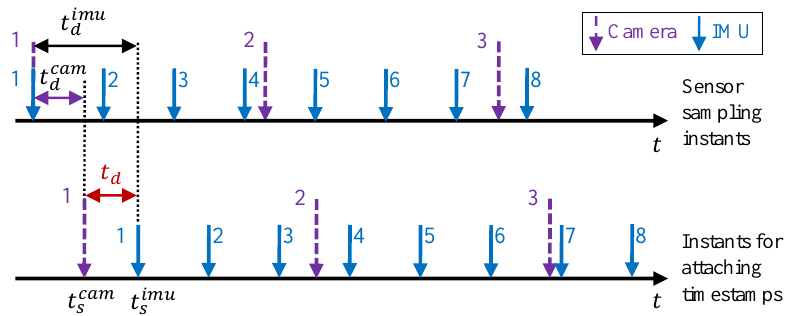
Figure 1. An example of temporal misalignment in the sensor data. The upper plot represents the sensor sampling instants. The lower plot shows instants for attaching timestamps. The timestamped data are essentially the sensor measurements obtained by users. The meanings of the notations are as follows. t imu and t cam are, respectively, the latency of Inertial Measurement Unit (IMU) and d d − t cam camera. t d = t imu is the time offset between the stamped IMU and camera data. These two d d timestamped data can be aligned by shifting the camera data with t d offset or shifting the IMU data with − t d